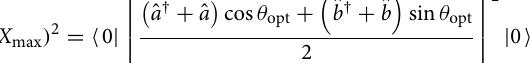
√ ω a ω b / 2 (indicated by arrows), whereas the actual minimum point is shifted around the critical strength g ≈ due to finite N 14,15 . ω a and N 64 2 2 4 (blue dash-dotted line), 2 6 Figure 3b shows (� X min ) 2 as a function of g for ω b = = = = 1024 (yellow line). We can find that, with the increase in N , the minimum position (red dashed line), and 2 10 = √ ω a ω b / 2 , and the minimum (� X min ) 2 monotonically decreases. shifts towards g = 0.25 π In Fig. 3e, f, the optimal angle θ opt is plotted as a function of g . As we have seen in Fig. 2, θ opt ≈ − ω a ). However, θ opt depends on ω b /ω a , g /ω a , and N , in general. for g (cid:31) 0.5 ω a in the zero-detuning case ( ω b = β r plane along the The anti-squeezing is quantified by the variance (� X max ) 2 of W (α r , β r ) in the α r − axis [broadening in Fig. 2a, c, e], which was evaluated by